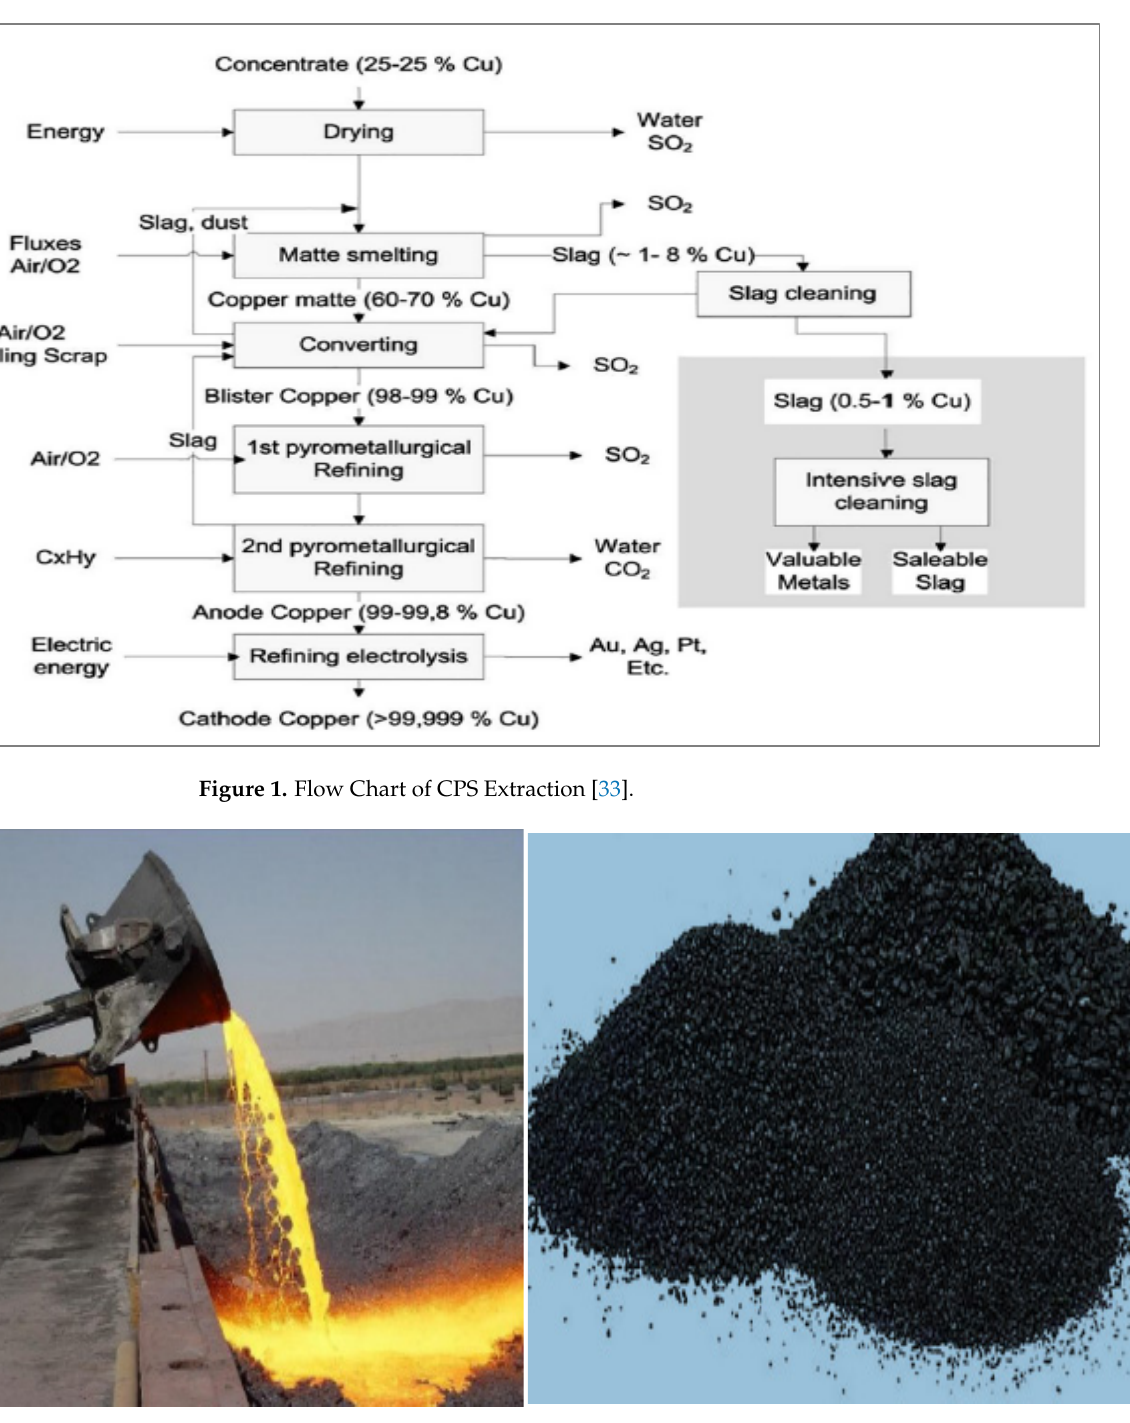
Figure 2. Cooling of CPS in air [33,34].